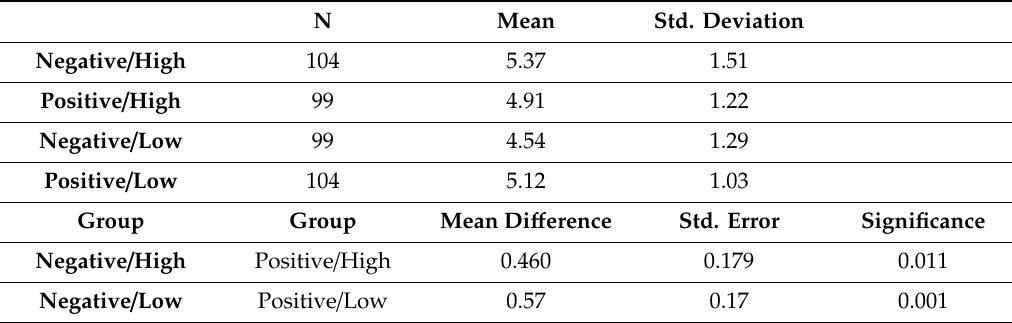
Table 8. Follow-up contrast analysis (frame and risk perception).